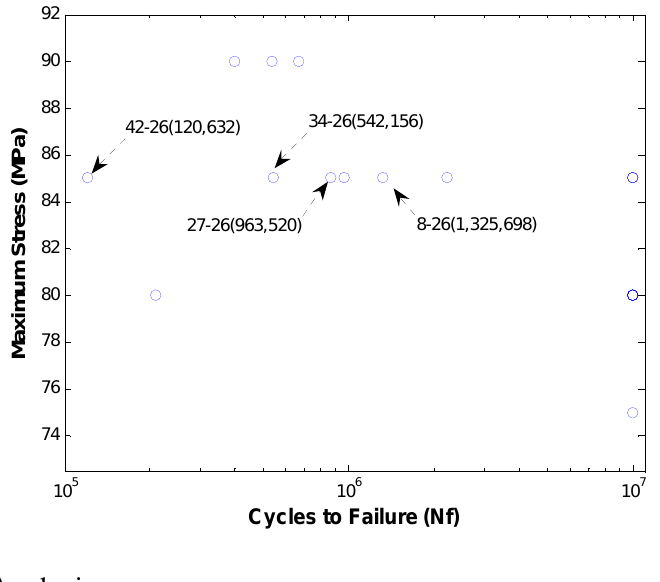
Figure 9. Specimen’s fatigue life subjected to several stress ranges